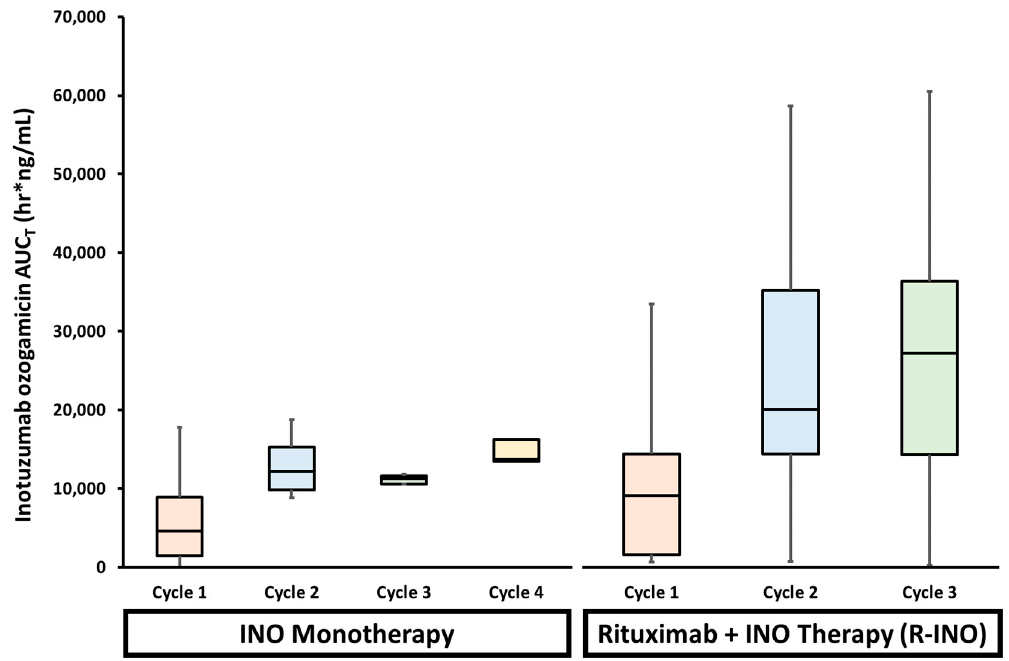
Figure 4. Serum inotuzumab ozogamicin (INO) exposures (AUC T ; cycle one in orange, cycle two in blue, cycle three in green, and cycle four in yellow) in patients receiving INO monotherapy or in combination with rituximab (R-INO). R-INO combination therapy demonstrated a higher variability in INO AUC T compared to INO monotherapy. In addition, INO exposure was ~three-fold higher in patients receiving combination therapy compared to monotherapy. These findings suggest that combining two immunotherapeutic antibody agents may saturate shared mechanisms of clearance, thus increasing the likelihood of inter-patient variable exposure.